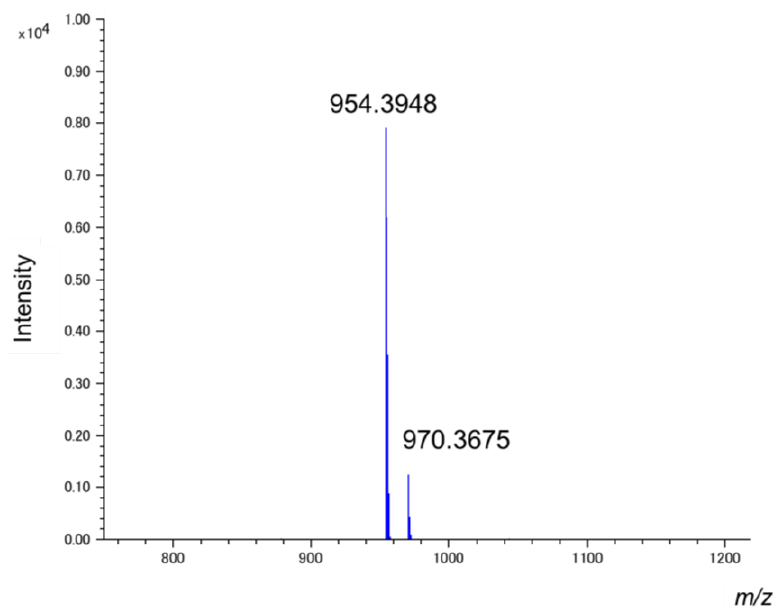
Figure 2. MALDI-TOF mass spectrum of N , N - bis(hexyl α -acetylmannosyl) acrylamide ( 3 ).